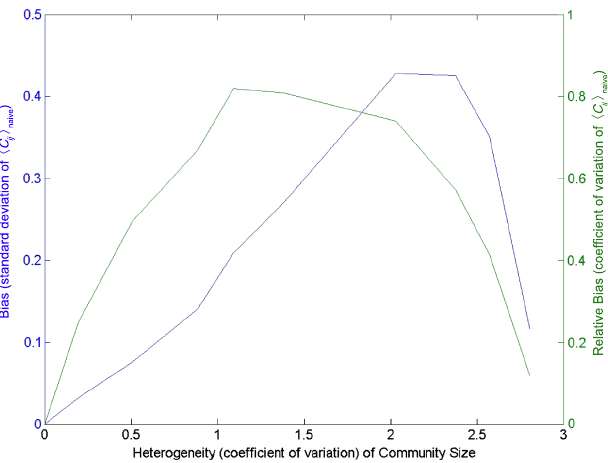
FIG. 3. Dependence of the (relative) bias of the naive approach on the heterogeneity (coefficient of variation) of community size, for various benchmarks with N ¼ 1000 time series and c ¼ 8 communities. The bias is defined as the standard deviation (coefficient of variation) of the off-diagonal entries h C of the null model defined in Eq. (32) with ϕ ¼ 1 , while the relative bias is defined as the coefficient of variation of the same entries (and is independent of ϕ